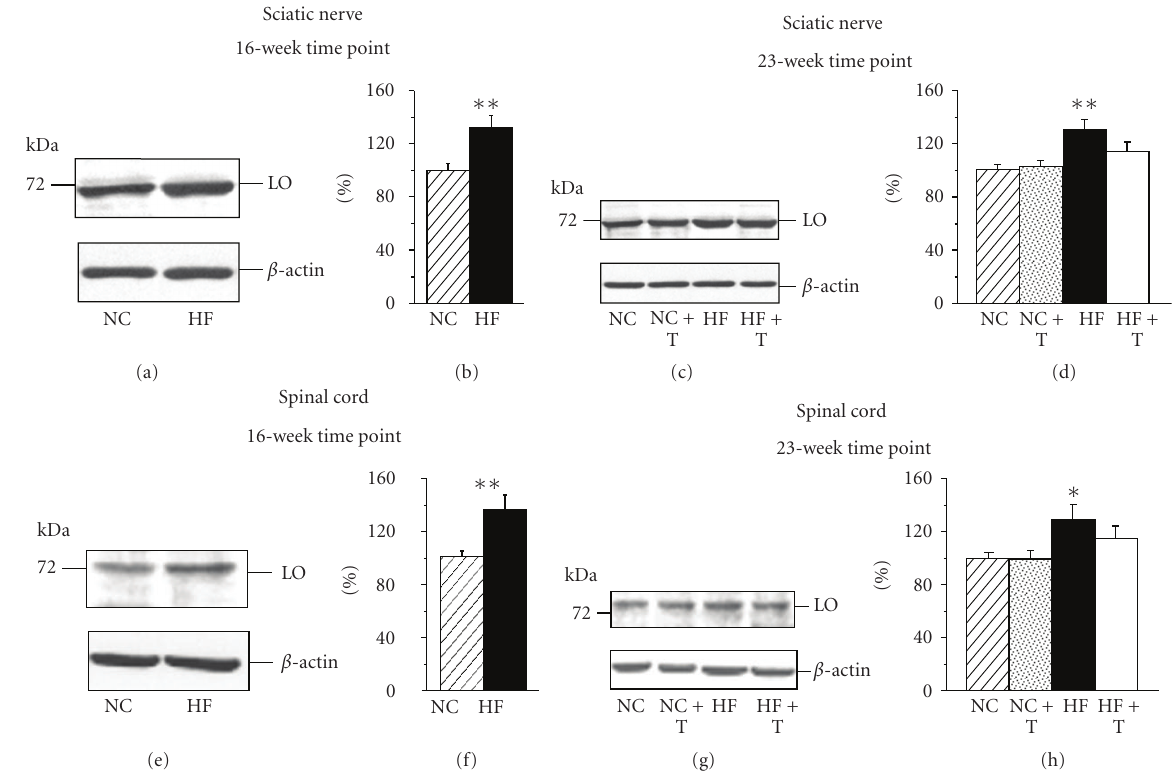
Figure 1: Representative Western blot analyses ((a), (c), (e), (g)) and content (densitometry, ((b), (d), (f), (h))) of mouse sciatic nerve ((a)–(d)) and spinal cord ((e)–(h)) 12/15-lipoxygenase expressions after 16-week ((a), (b) and (e), (f)) and 23-week ((c), (d) and (g), (h)) feedings with normal chow or high-fat diet with or without PMI-5011. NC: normal chow, HF: high fat diet, T: treatment. Mean ± SEM, n = 7-8 per group. ∗ , ∗∗ P < . 05 and < . 01 versus mice fed NC.